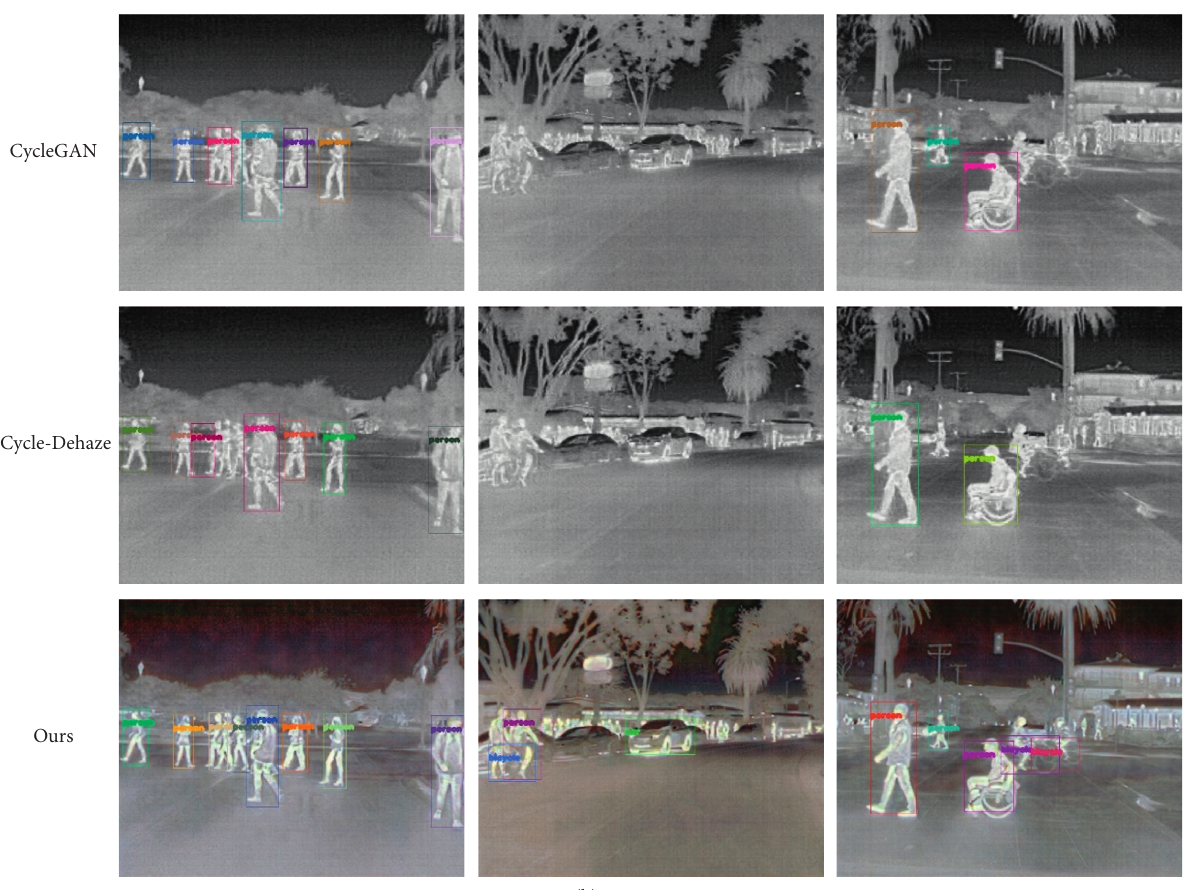
Figure 11: Deblurring image target detection